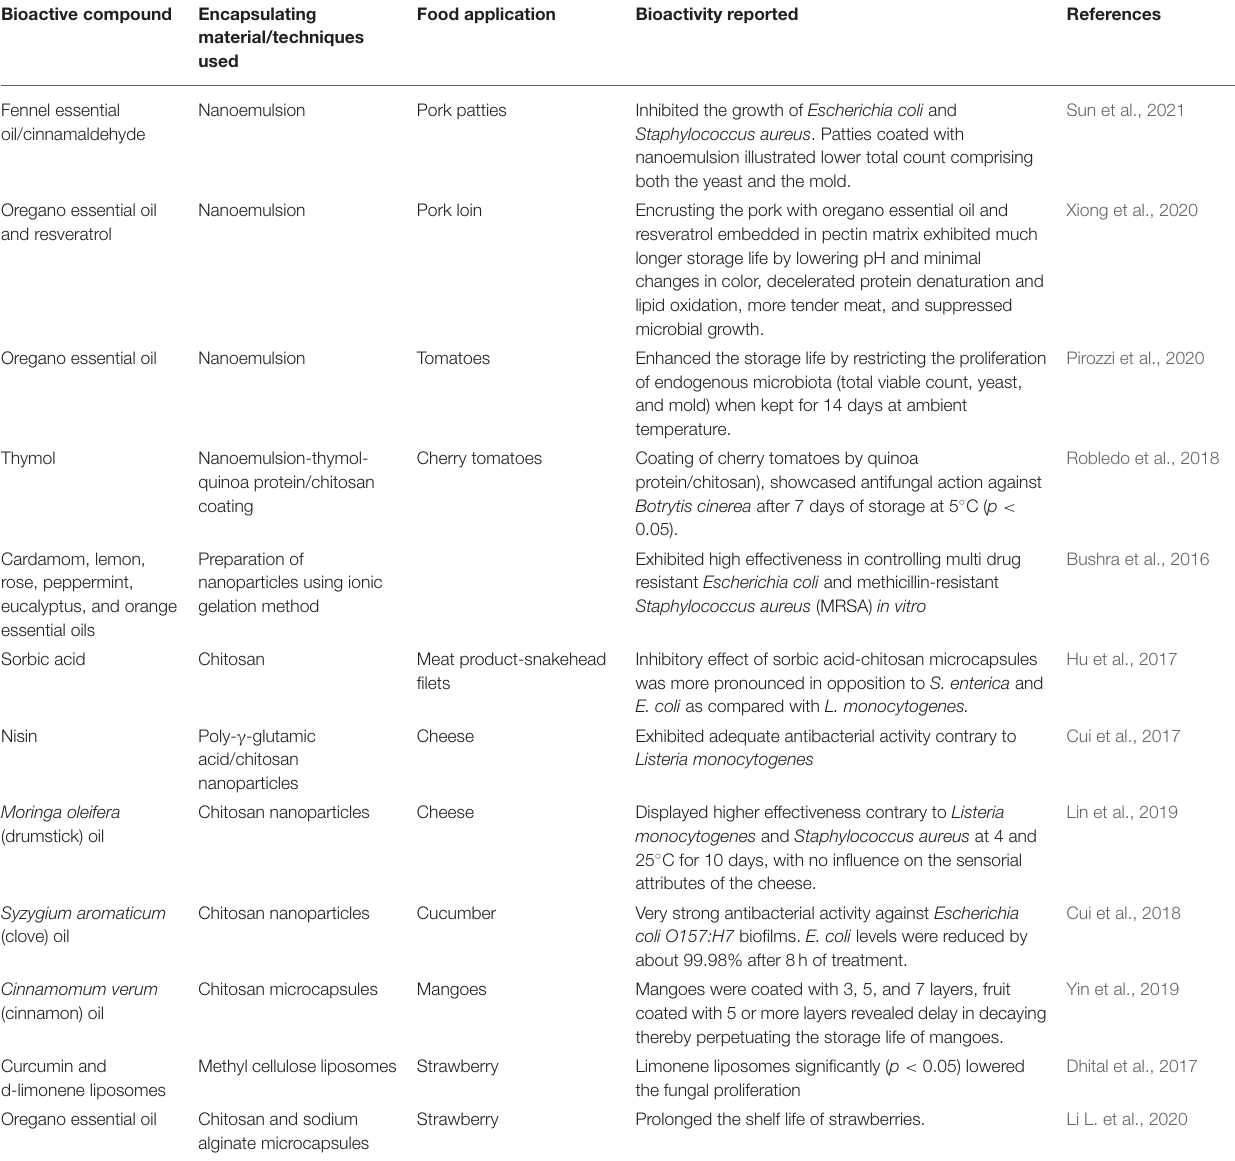
TABLE 2 | Highlights of studies pertaining to incorporation of encapsulated antimicrobial conglomerates in edible